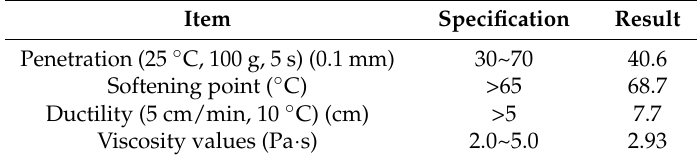
Table 3. Technical properties of microwave-activated crumb rubber-modified asphalt (MACRMA). Item